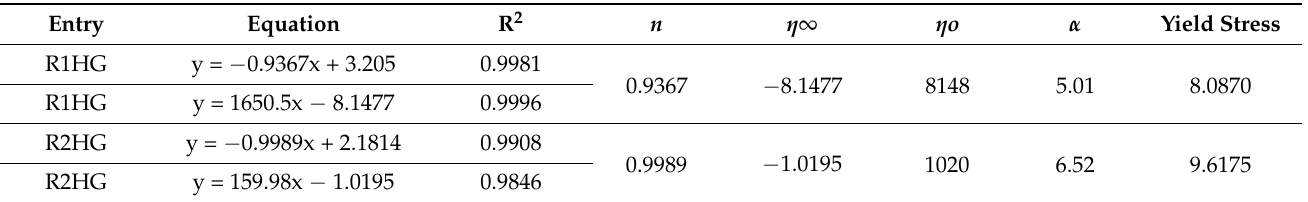
Table 4. Equations, coefficients of determination (R 2 ), parameters of Cross equation, and values of yield stress obtained for R1HG and R2HG.